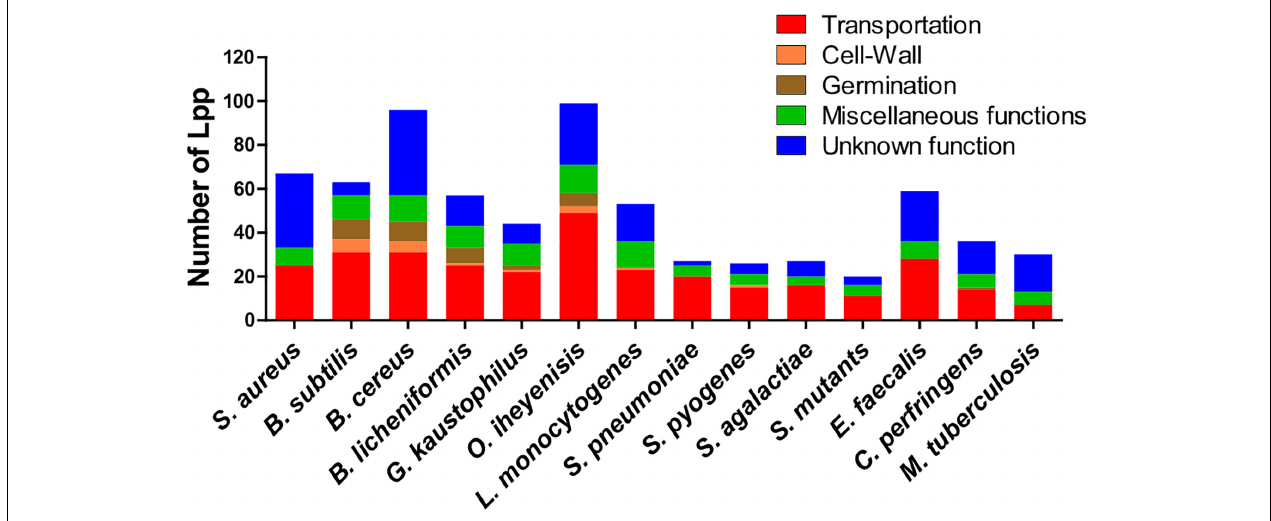
FIGURE 1 | Lipoproteins content in 14 Gram+ bacterial species. Lpp are categorized by their function such as transportation, cell-wall turnover, germination, miscellaneous functions and unknown function. A more detailed information of Lpp in each group are presented in Supplementary Table S1–S13 for 13 species ( Bacillus subtilis , Bacillus cereus , Bacillus licheniformis , Geobacillus kaustophilus , Oceanobacillus iheyenisis , Listeria monocytogenes , Streptococcus pneumoniae , Streptococcus pyogenes , Streptococcus agalactiae , Streptococcus mutants , Enterococcus faecalis , Clostridium perfringens , and Mycobacterium tuberculosis ). Data for Staphylococcus aureus Lpp are taken from Shahmirzadi et al.